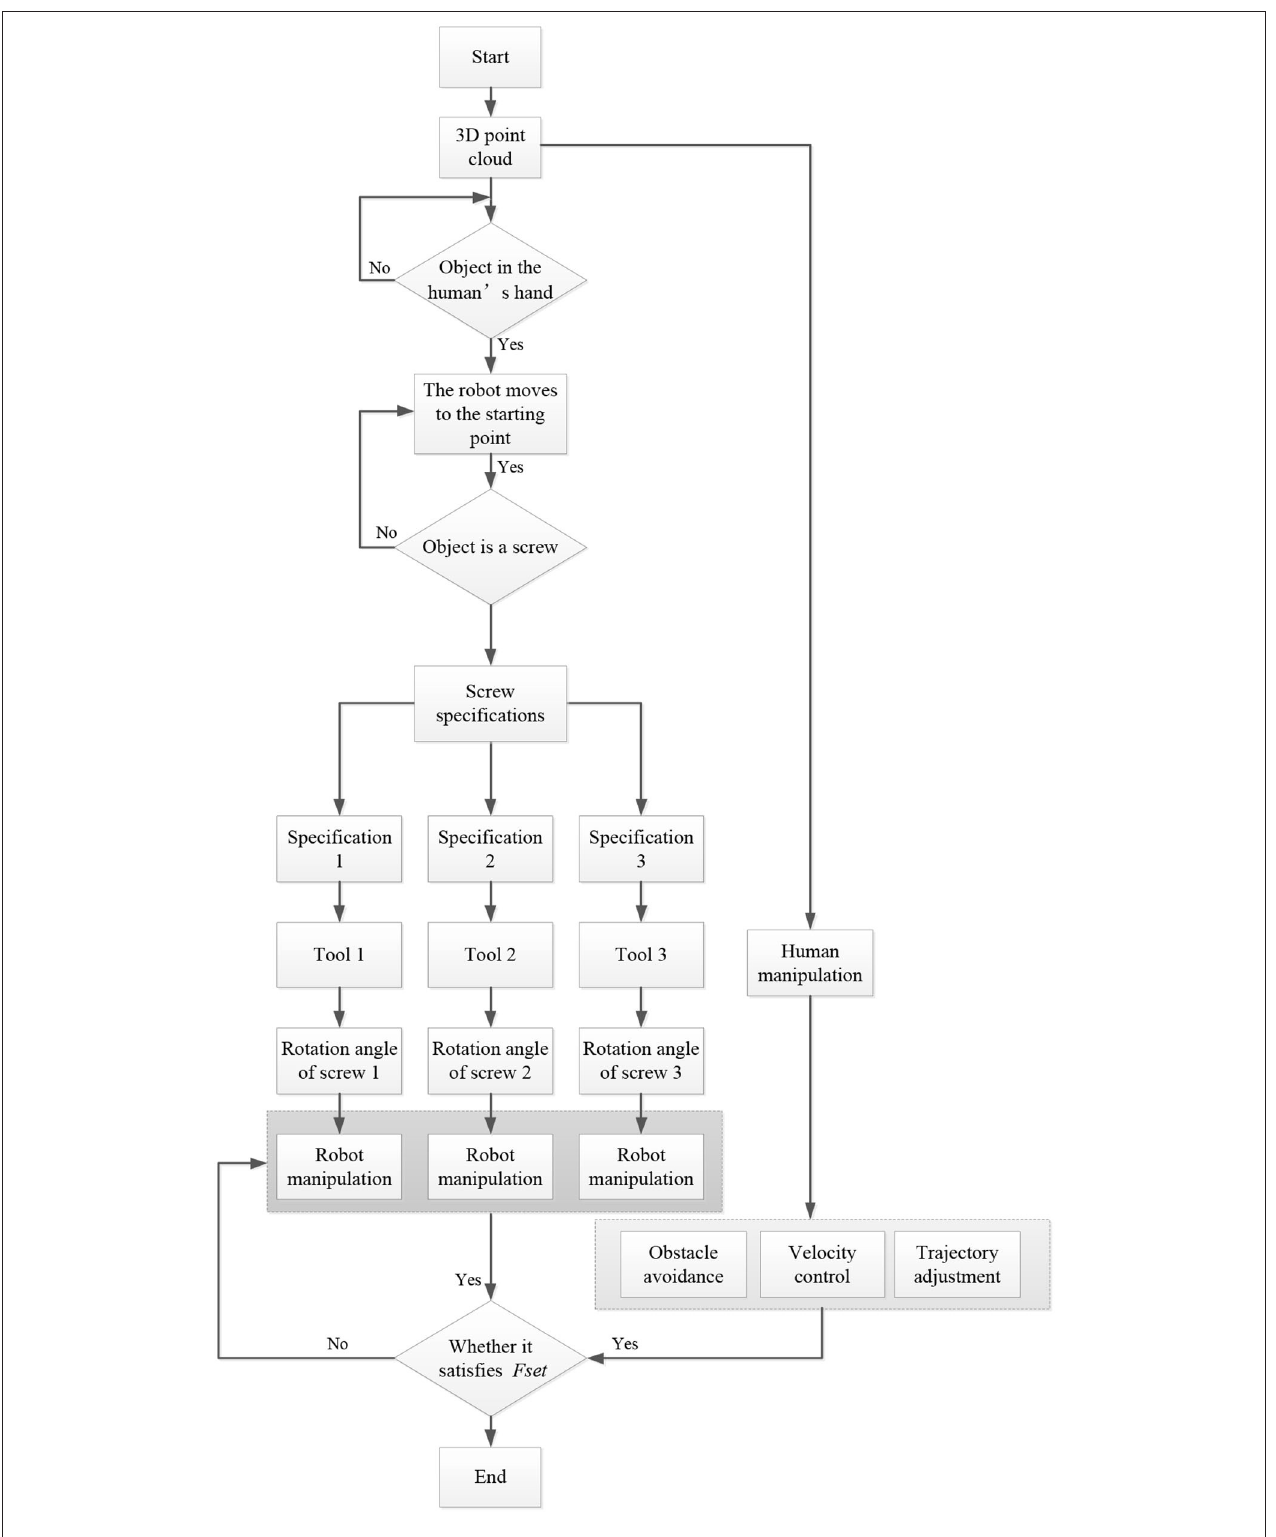
FIGURE 7 | Flowchart of the